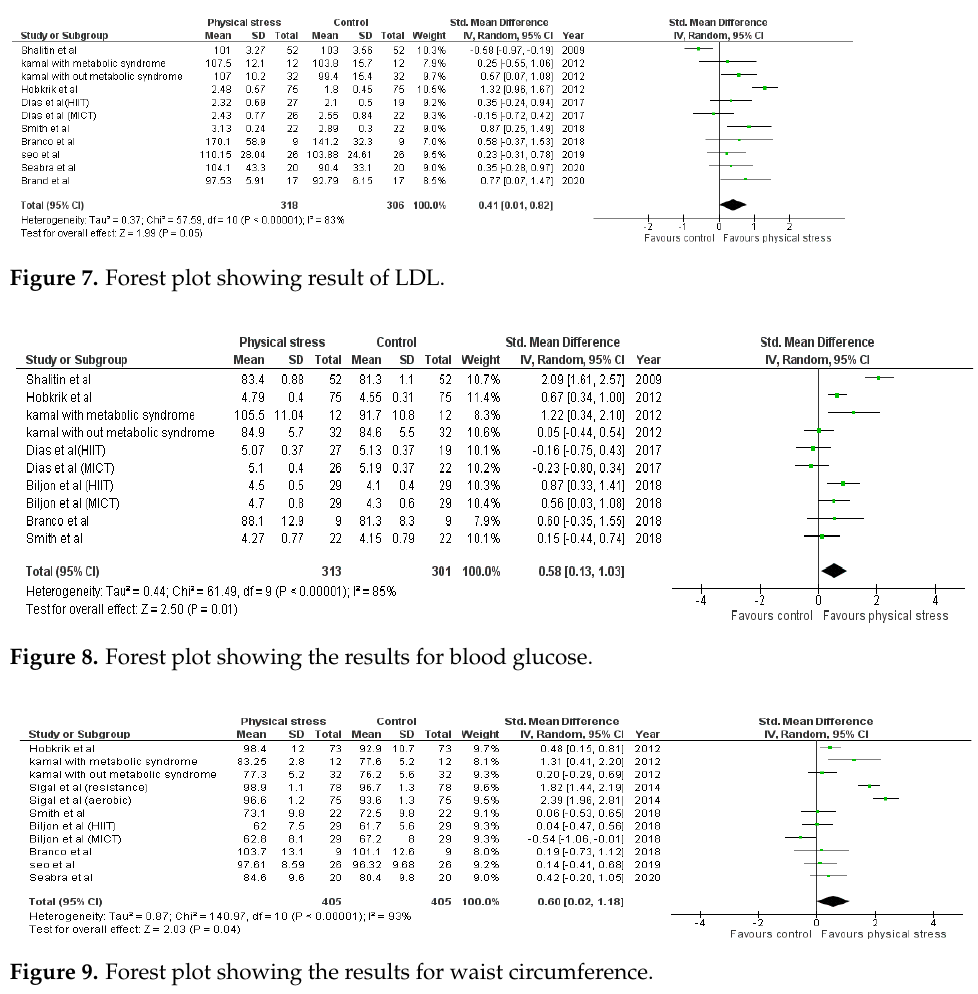
9 of 16 Figure 4. Forest plot showing the results for DBP. 3.4.4. Systolic Blood Pressure Out of 12 studies, 8 reported data for Systolic blood pressure. Pooled results (Figure 5) showed that Systolic blood pressure was not statistically significant in the comparison with the control group (0.89 95% CI -0.02, 1.80; p = 0.05; I 2 = 97%). Figure 5. Forest plot showing the results for SBP. 3.4.5. High-Density Lipoprotein (HDL) Out of 12 studies, 10 reported data for HDL. Pooled results (Figure 6) showed that HDL level was not statistically significant in the comparison with the control group (-0.48 95% CI -1.06, 0.11; p = 0.11; I 2 = 92%).